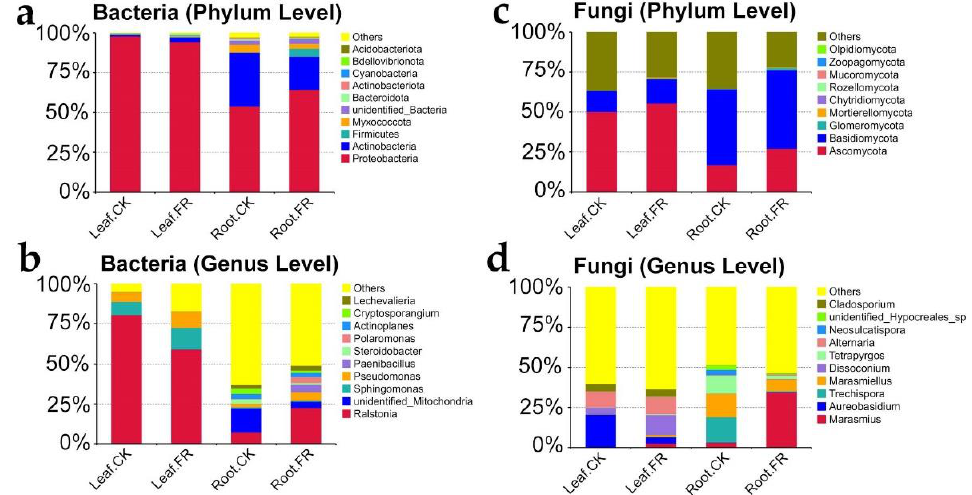
Figure 4. Endophyte community composition and LEfSe analysis of bacteria and fungi in LC of the FR and CK zones of the fairy ring ecosystem. The relative abundance of bacterial community at the ( a ) phylum and ( b ) family levels. The relative abundance of fungal community at the ( c ) phylum and ( d ) family levels.